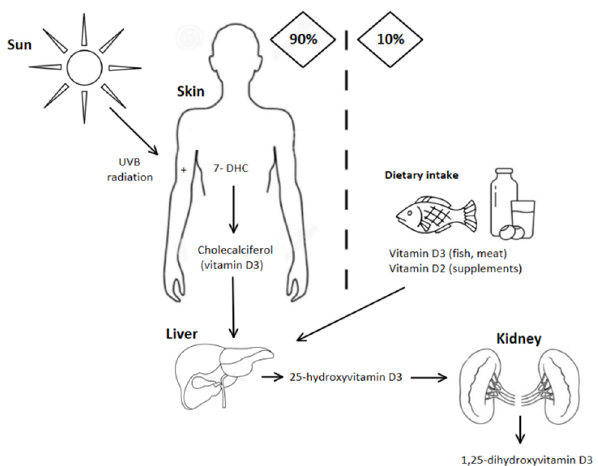
Figure 1. The sources and metabolism of vitamin D. About 90% of vitamin D derives from skin production. Vitamin D precursor (7-dehydrocholesterol) is converted to previtamin D. Is it further converted to vitamin D (cholecalciferol). To become the active metabolite, it is hydroxylated in the liver and then in kidneys [1,3].